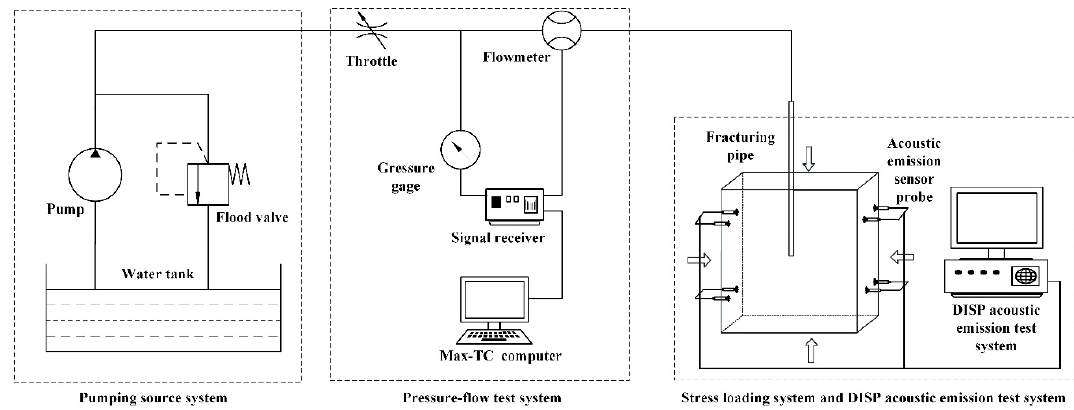
Figure 6. Schematic diagram of the hydraulic fracturing system model employed in the experimental study.